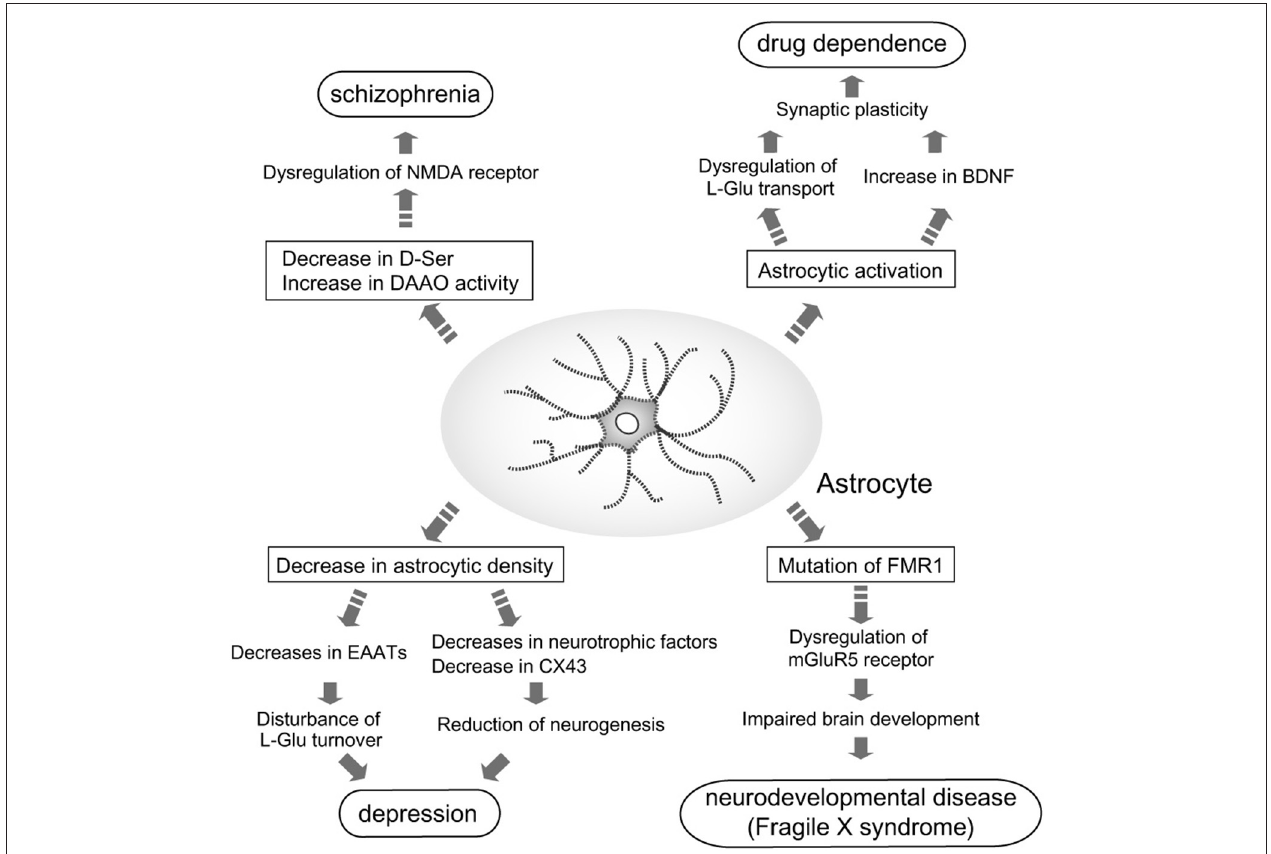
factors, CX43 and excitatory amino acid transporters (EAATs). Decreases in these astrocytic molecules cause disturbance of L-Glu turnover and neurogenesis, which may aggravate depression. Many dependence-producing drugs activate astrocytes. Production of brain-derived neurotrophic factor (BDNF) by reactive astrocytes enhances the rewarding effects of psychostimulants. fragile X mental retardation 1 (FMR1) is the gene responsible for FXS. Mutations in FMR1 cause dysfunction of mGluR5 signaling in neurons and astrocytes, which impairs normal brain